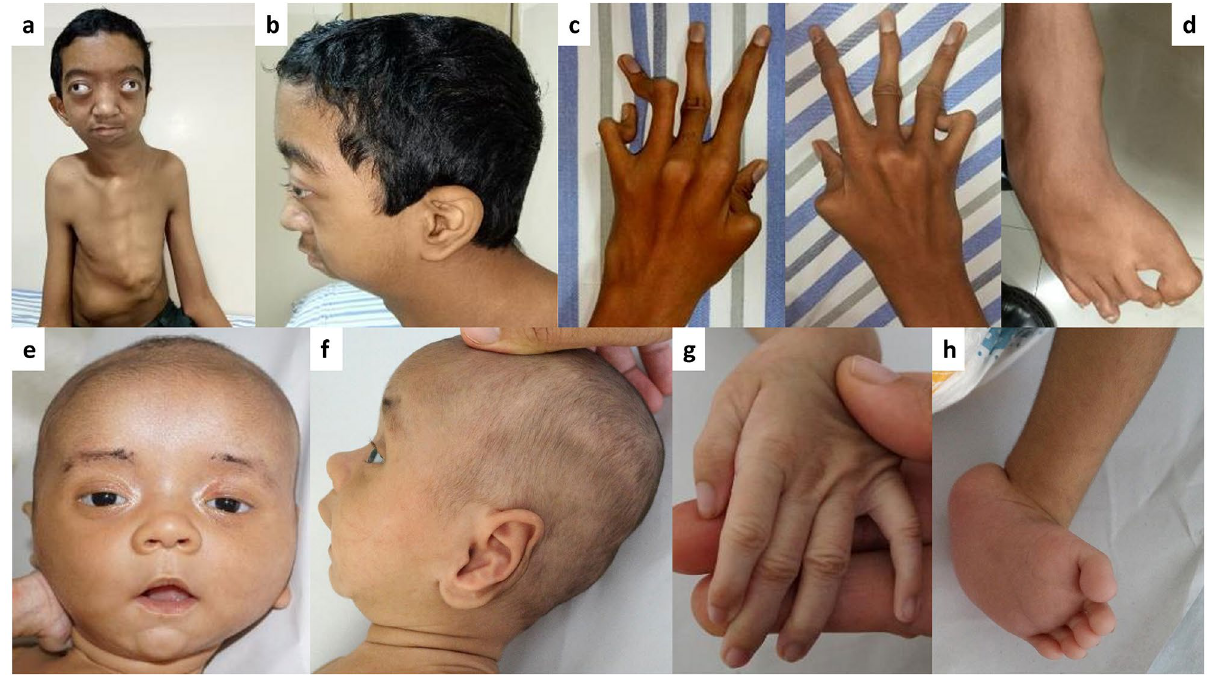
Figure 4. Clinical photographs of patients with SGS. Craniosynostosis, dolichostenomelia, low-set ears, overfolded ear helix, proptosis, downslanted palpebral fissures, hypertelorism, proptosis, alternative exotropia, vertical strabismus of left eye, microcornea, depressed nasal bridge, underdeveloped cheekbone, thin vermilion of upper lip, micro-retrognathia, pectus carinatum and kypho-scoliosis can be noted in patient 37 at age 13.5 years ( a , b ). He also had long and narrow fingers with camptodactyly ( c ), long and narrow feet with camptodactyly, pes planus and metatarsus adductus ( d ). The second patient (Patient 38), at 3 months of age, shows wide anterior fontanel, long ears, hairy pinnae, excess scalp skin, short and downslanted palpebral fissures, hypertelorism, depressed nasal bridge, inverted V shaped upper lip with think vermilion ( e , f ), long and narrow fingers ( g ) and bilateral talipes equinovarus ( h ).